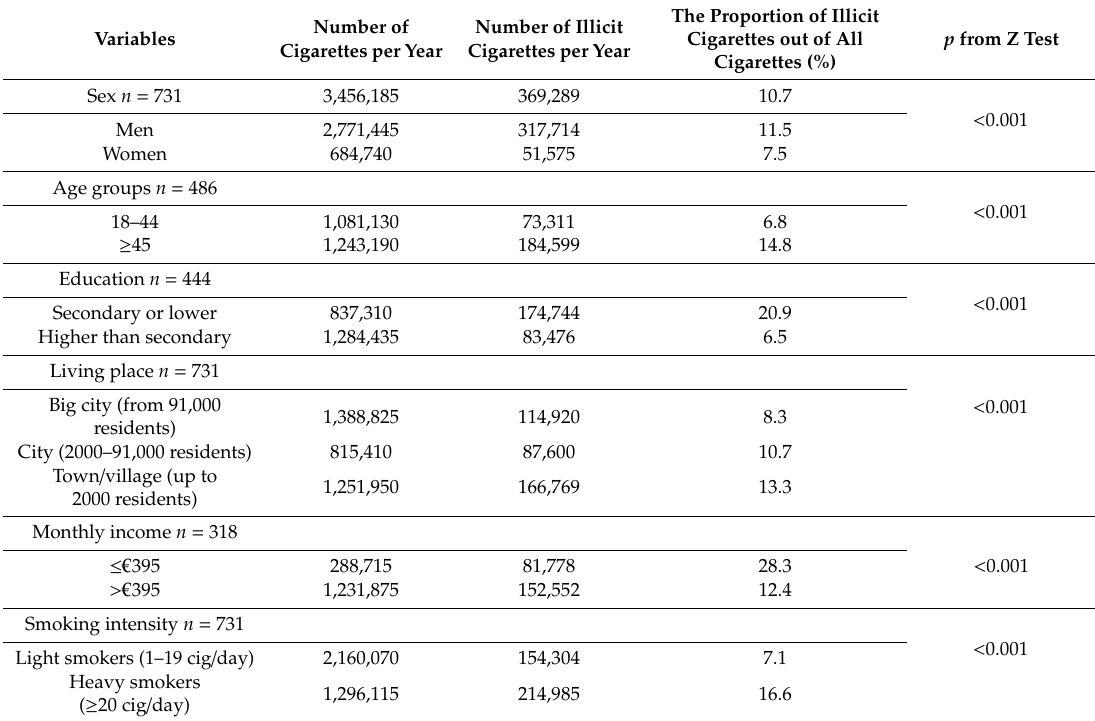
Number of cigarettes smoked per year and the proportion of illicit cigarettes by socio–demographic characteristics and smoking